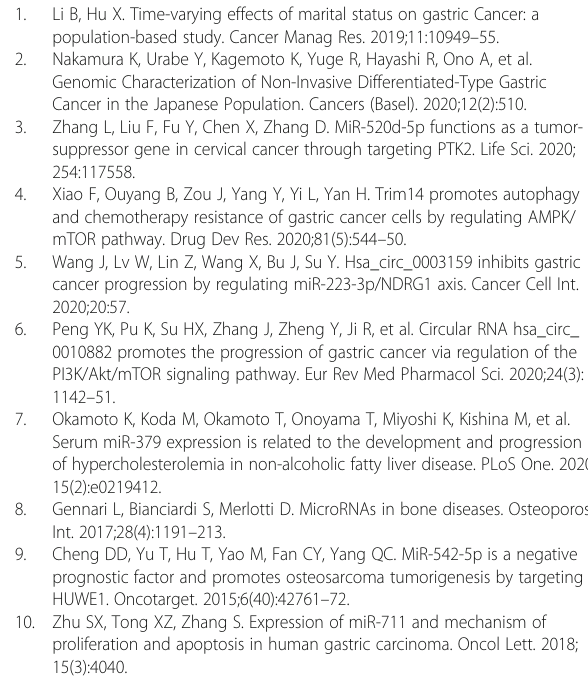
Additional file 1: Figure S1. Melting curves of U6 (A) and GAPDH (B).